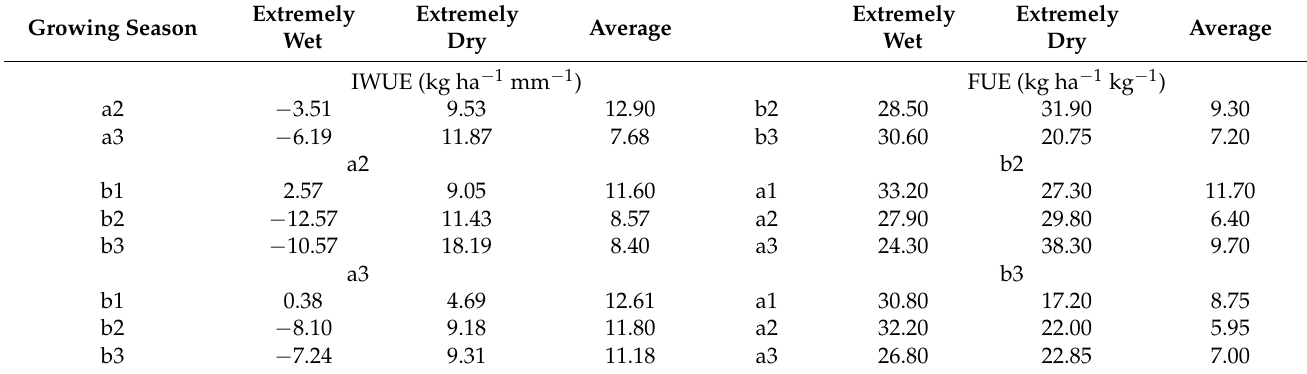
Table 5. Irrigation water use efficiency (IWUE) and fertilizer use efficiency (FUE) in different weather conditions, irrigation levels, and N fertilizer